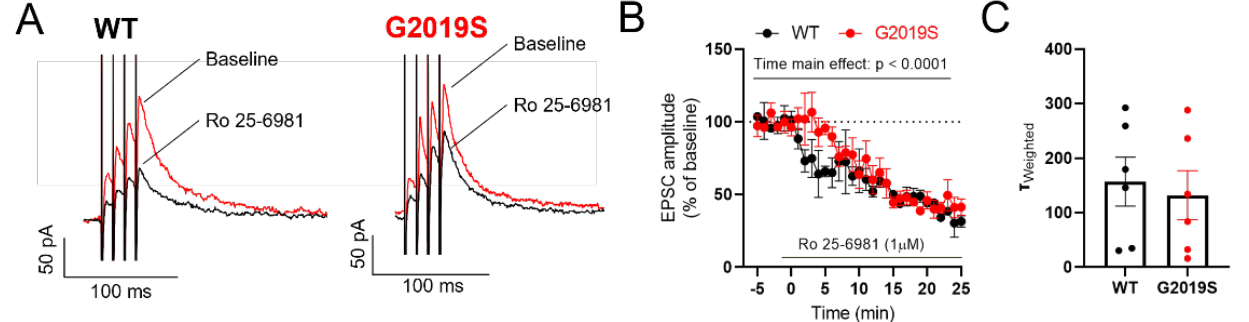
Figure 3. Unaltered synaptic NMDARs in SNr neurons of G2019S. ( A ) Example traces of NMDAR- EPSCs—before (red traces) and during (black traces) bath application of the GluN2B antagonist Ro 25-691 (1 µ M)—recorded in two SNr neurons from a WT mouse and a G2019S mouse. ( B ) Time course of the effect of Ro 25-2981, applied at the time indicated by the horizontal bar, on NMDAR-EPSC amplitude in SNr neurons from WT and G2019S mice. Ro 25-691 inhibited the NMDAR-EPSC to a similar level in WT and G2019S mice (WT: n = 3 cells from N = 3 mice; G2019S: n = 4 cells from N = 4 mice; 2-way ANOVA, factors genotype and time, main effect of time: F 35, 188 = 11.61, p < 0.0001). ( C ) No differences were detected in the kinetic properties of NMDAR-EPSCs in the SNr between WT and G2019S mice (WT: n = 6 cells from N = 5 mice; G2019S: n = 6 cells from N = 5 mice).